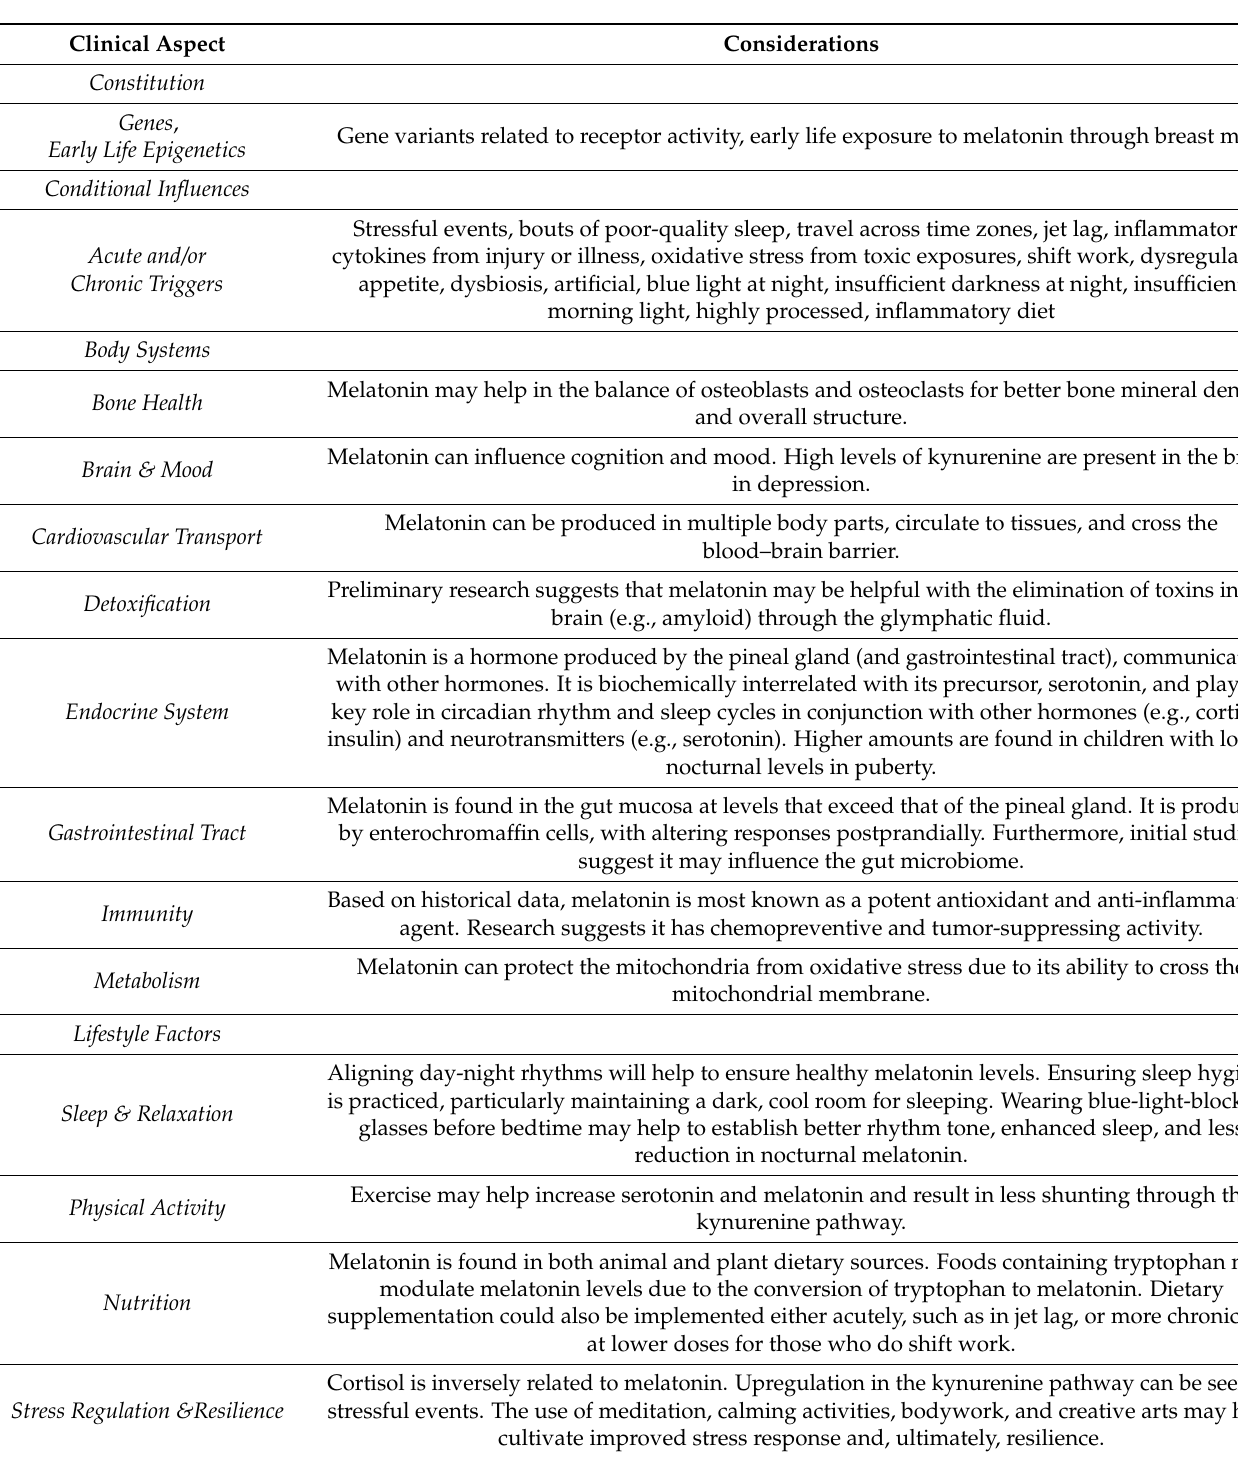
Table 7. A General Clinical Framework for Assessing